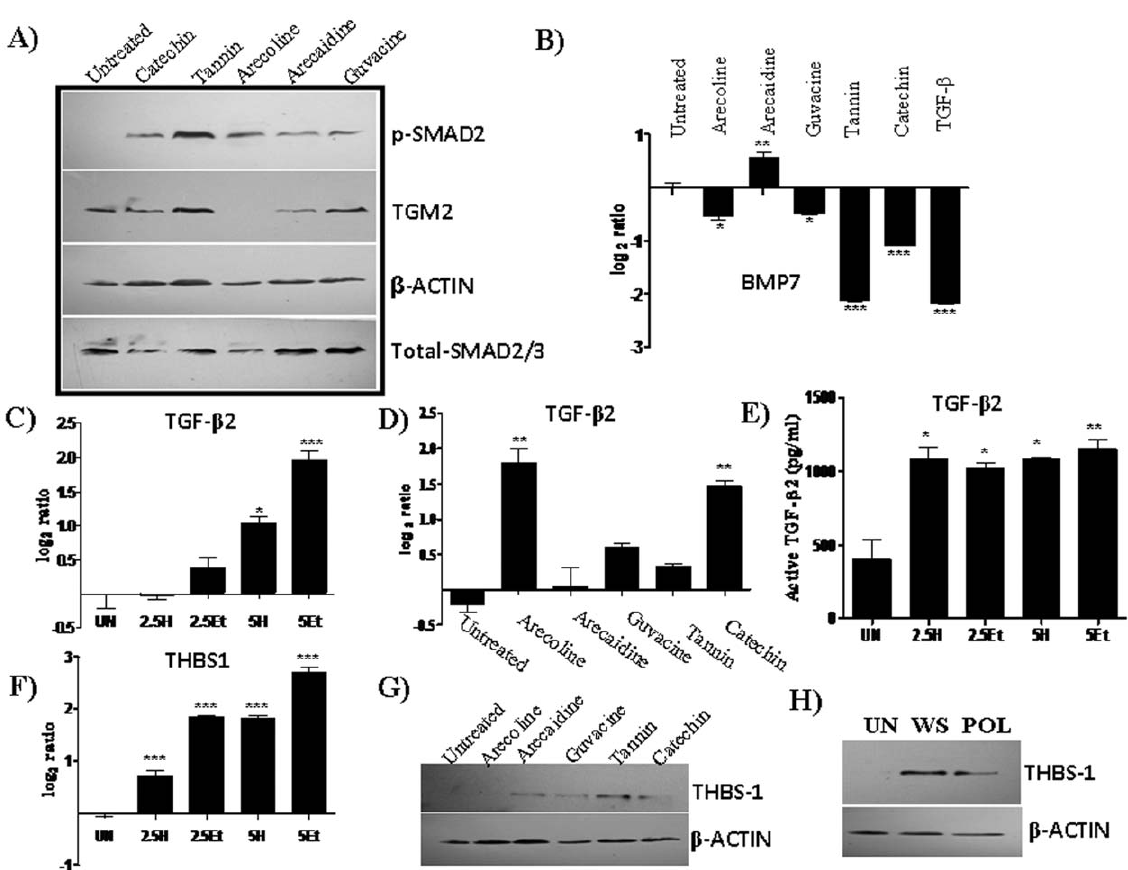
Figure 4. Both the pure alkaloids and polyphenols of areca nut induce TGF- b signaling. Human keratinocytes (HaCaT) cells were serum deprived for 24 hours and treated with areca nut extracts, pure Alkaloids and Polyphenols for 48 hrs. A, shows pSMAD2 by western blot and B, expression of BMP7 by real time PCR; C & D, TGF- b 2 expression by real time PCR; E, TGF- b 2 protein estimation by ELISA; F, THBS1 expression by real time PCR; G & H, THBS1 western blots. The treatments are depicted in the respective figures. UN- untreated, Arecoline (400 m M),